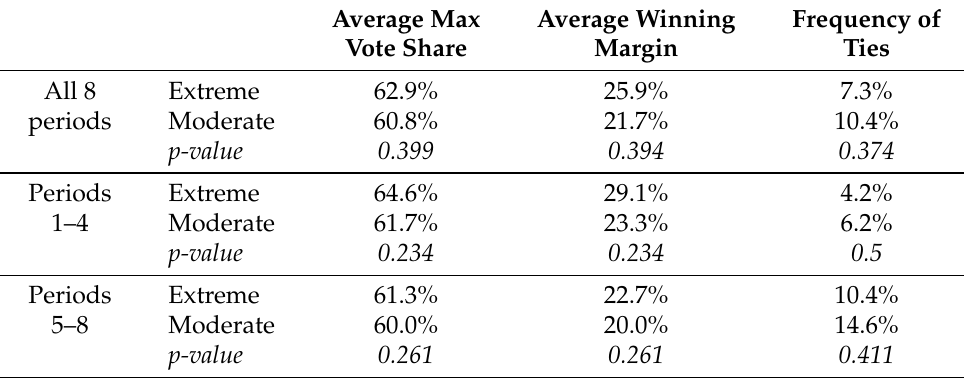
Table A1. First Series of